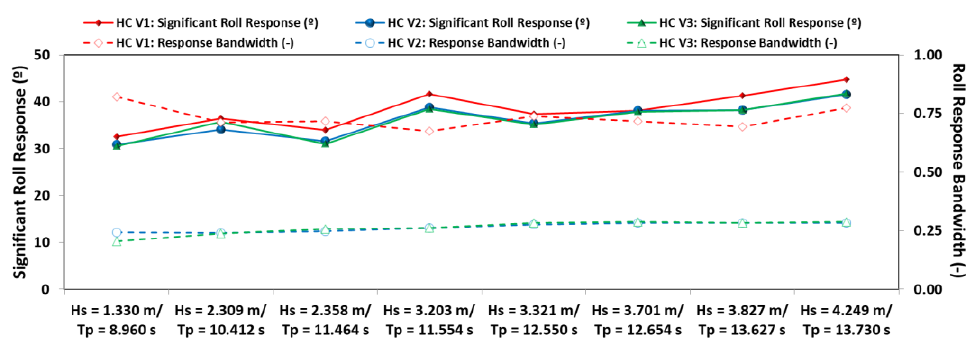
Figure 11. 𝜁 𝑚0,4 (left) and 𝜖 4 (right) for the HC sub-variants.